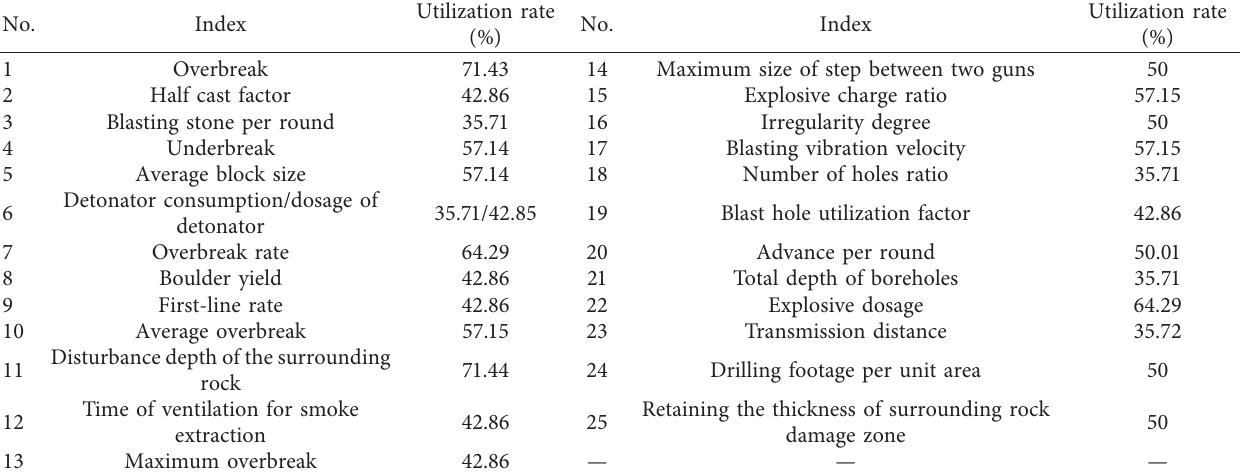
Table 1: Quantitative indices obtained via site investigation and expert